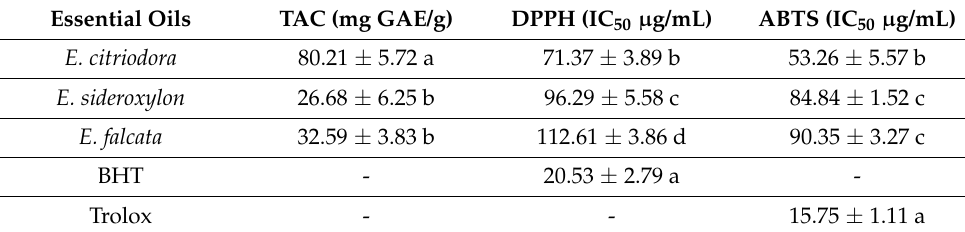
Table 3. Antioxidant activity of the essential oils of the three Eucalyptus species.